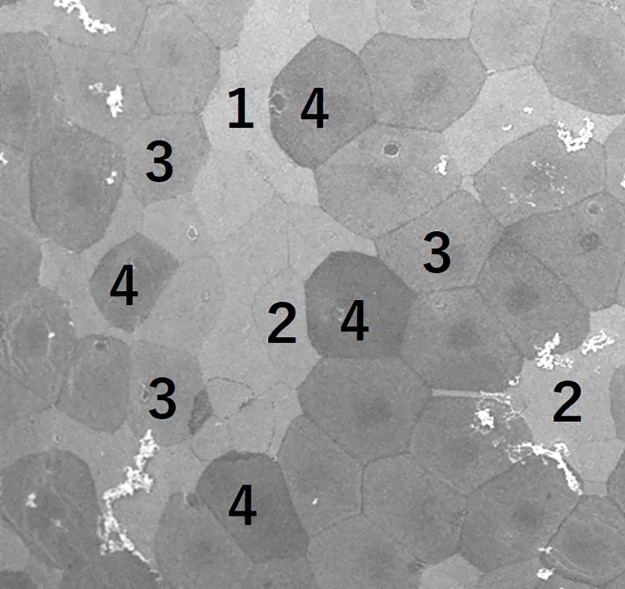
Grading of cell brightness in the corneal epithelium shown at 400x magnification.The corneal epithelial cells were subdivided into 4 intensity levels from lightest to darkest and classified as either bright or dark cells. Cells with an intensity level of 1 or 2 were classified as “bright cells,” and cells with an intensity level of 3 or 4 as “dark cells”.